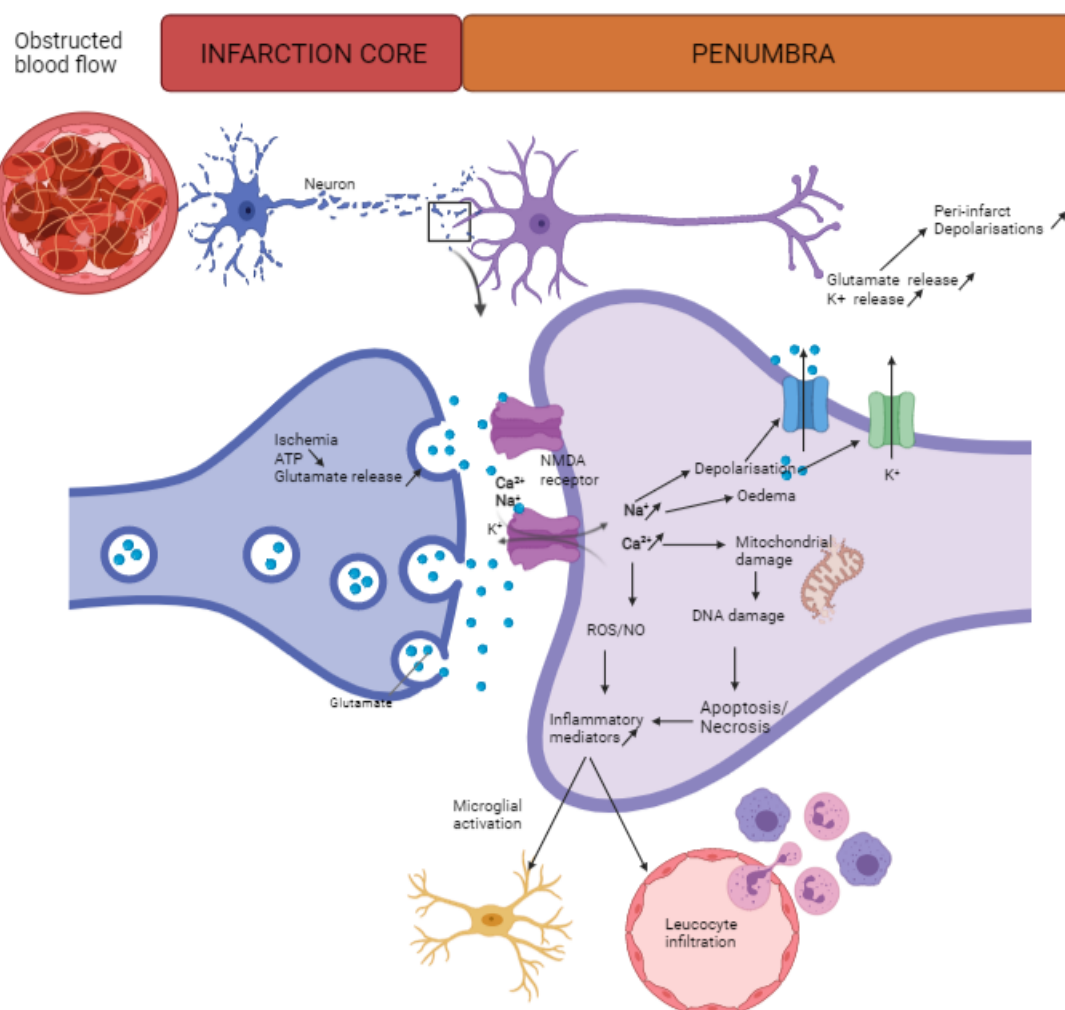
Figure 1. Overview of key events in the ischemic cascade: Ischemic stroke is caused by a sudden occlusion in the brain–blood supply. This results in irreversible damage of the neurons nearby the blood vessel, the ischemic core. This area is surrounded by the salvageable ischemic penumbra, in which neurons can be rescued if neuroprotective treatment is applied on time. In the core zone neurons, impaired oxygen and nutrient delivery results in a reduced ATP production, which will lead to loss of membrane potential and glutamate release. This will cause an ischemic cascade in neighboring neurons: the excess of glutamate will cause an increase in Na + and Ca 2+ influx, leading to cell swelling (edema) and depolarization, which will trigger K + efflux and glutamate release. In addition, the increase in intracellular Ca 2+ will also lead to mitochondrial damage as well as ROS and NO formation, both events causing mitochondrial damage and, thus, apoptosis and necrosis. This increased oxidative stress as well as the necrotic/apoptotic events lead to the secretion of inflammatory mediators, which exacerbate a negative effect of microglial activation and infiltration of native immune cells, such as neutrophils and macrophages [25,26]. Figure created with biorender.com (accessed on 1 May 2021).